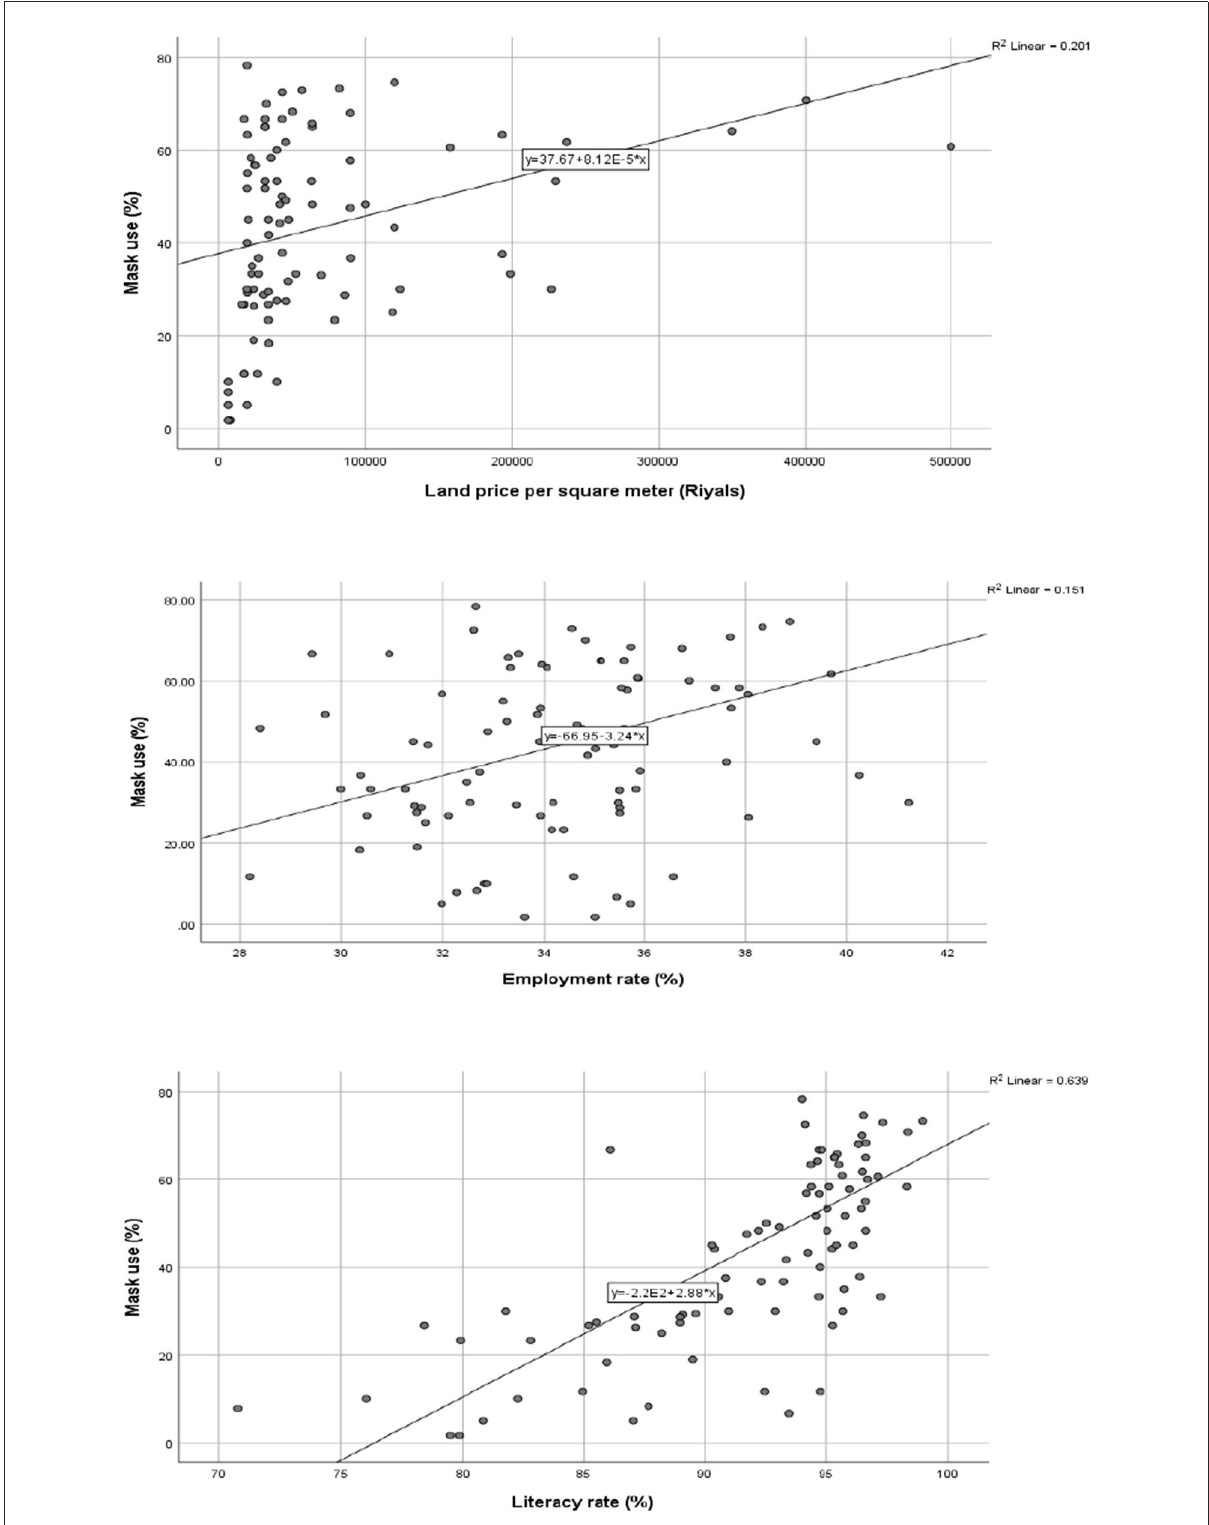
FIGURE1 Partial correlation between the SES indicators and prevalence of mask usage at the neighborhood level, controlled for age and